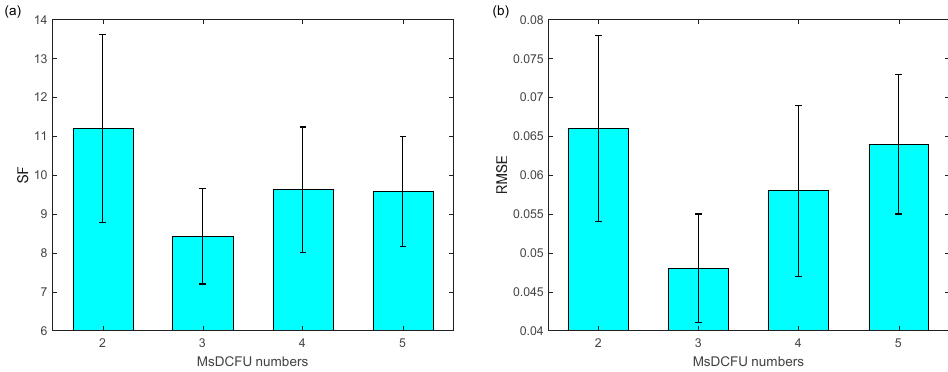
Figure 10. Evaluation indexes based on different MsDCFU numbers: ( a ) RMSE and ( b ) SF. Table 2. Comparison of model parameters and training time with different MsDCFU numbers.